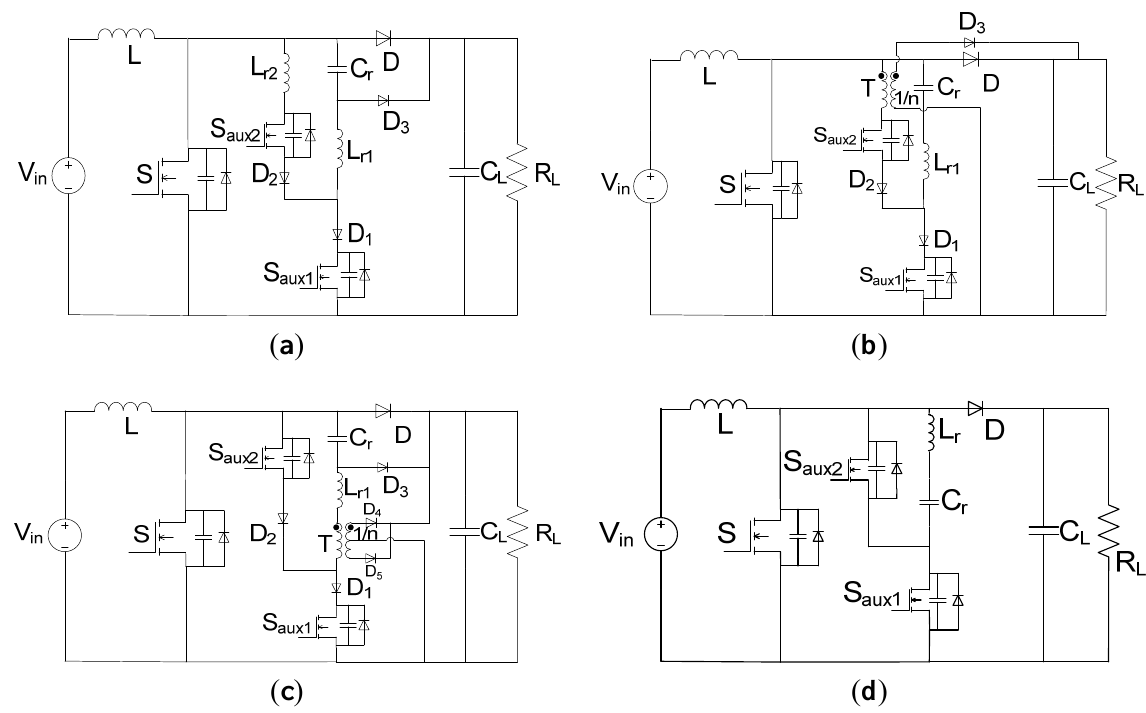
Figure 9. Modified structures of new aux